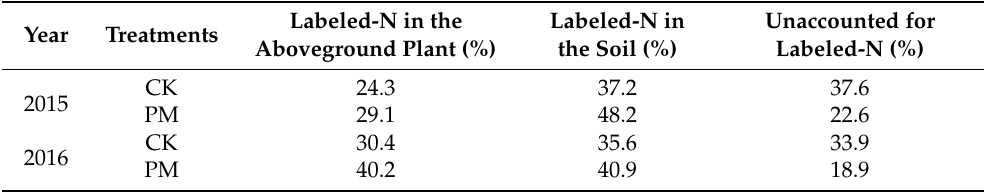
Table 2. Nitrogen budget based on the fate of 15 N (%) in the top 60 cm of soil at the maturity of spring maize under a fertilizer N rate of 225 kg N ha − 1 in